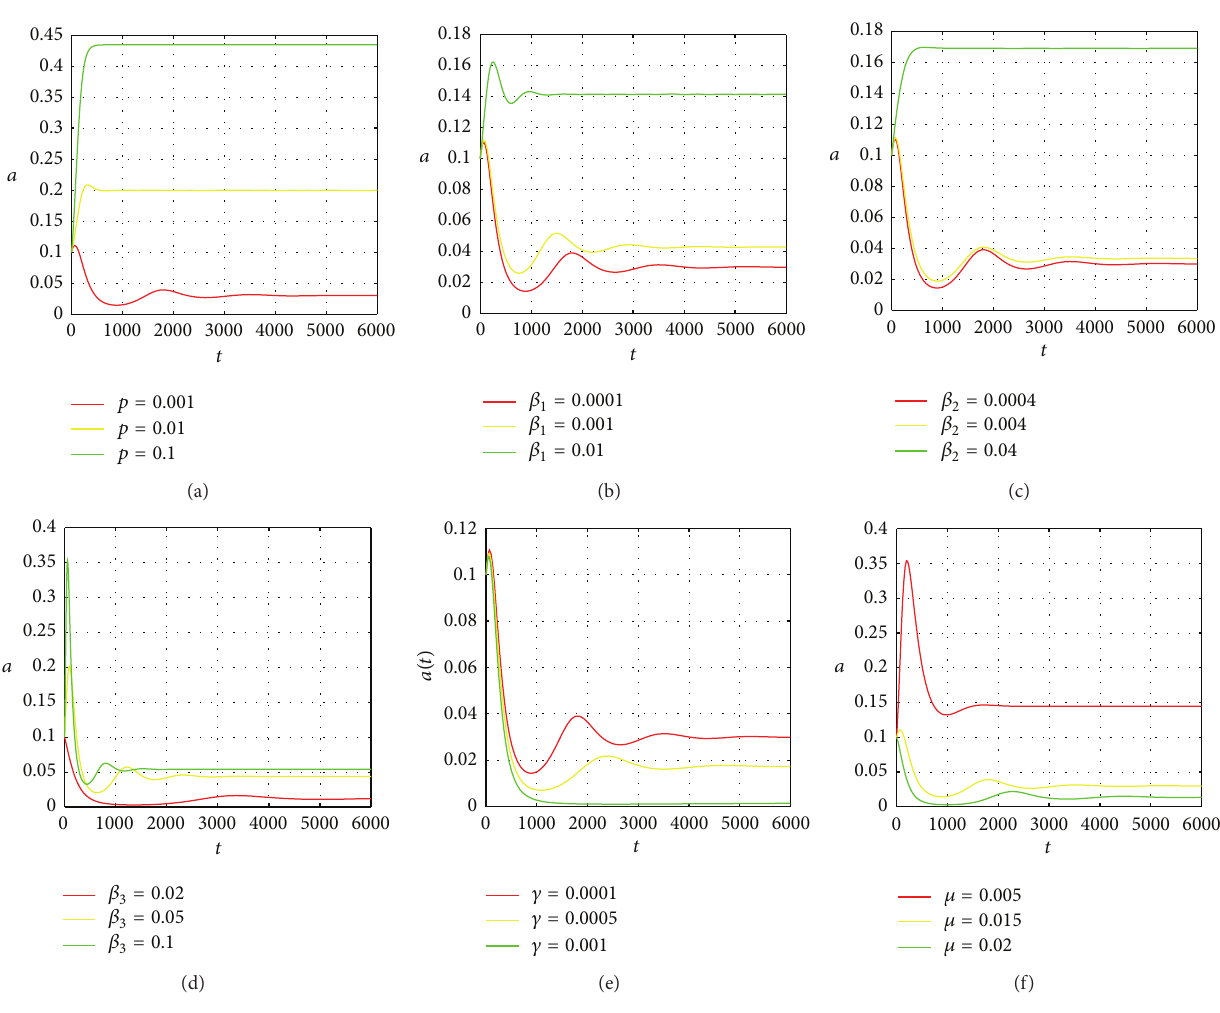
Figure 2: When 𝛼 = 0 , evolution of 𝑎(𝑡) for different values of 𝑝 , 𝛽 1 , 𝛽 2 , 𝛽 3 , 𝛾 , and 𝜇 ,